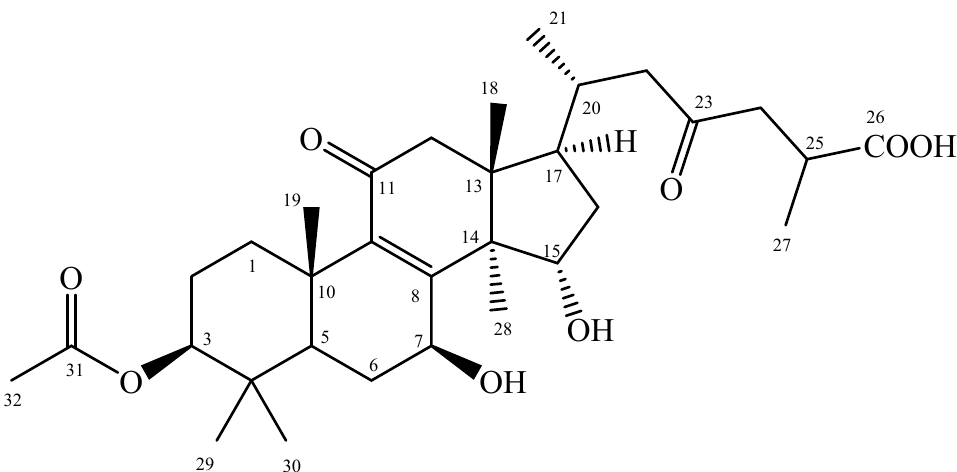
Figure 2. The chemical structure of the biotransformed metabolite compound ( 1 ), 3- O -acetyl ganoderic acid A.